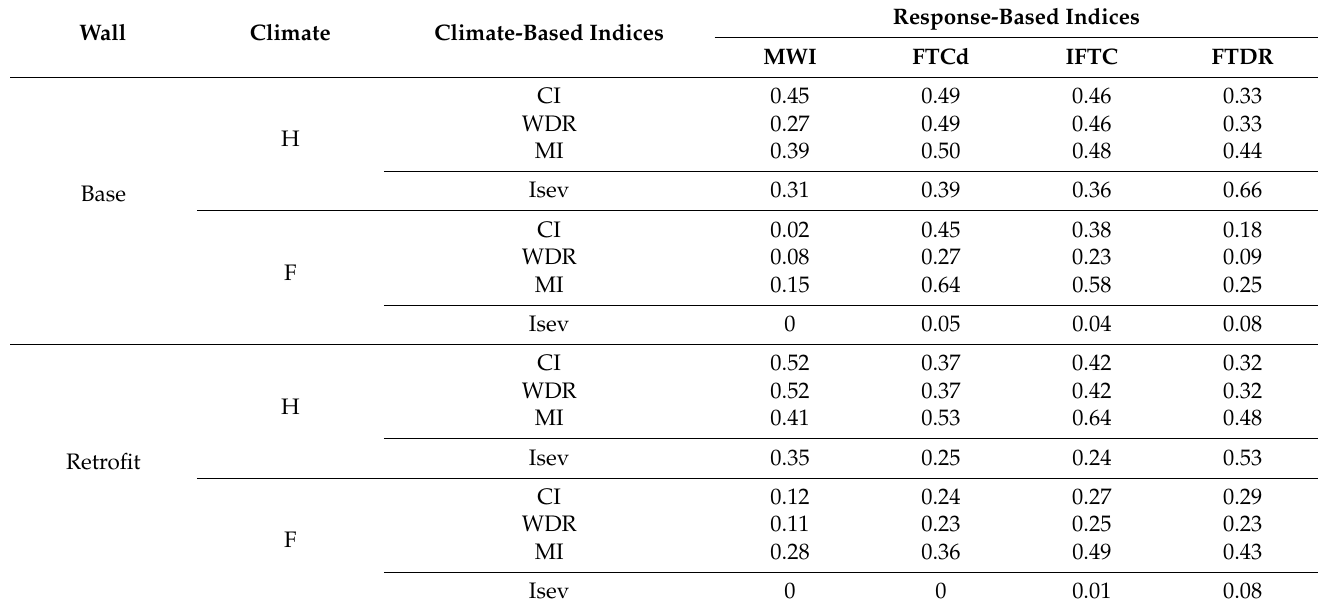
Table 6. Ratio of the average normalized values of the top three years based on climate-based indices and the simulation results for Vancouver for a wall facing the prevailing WDR